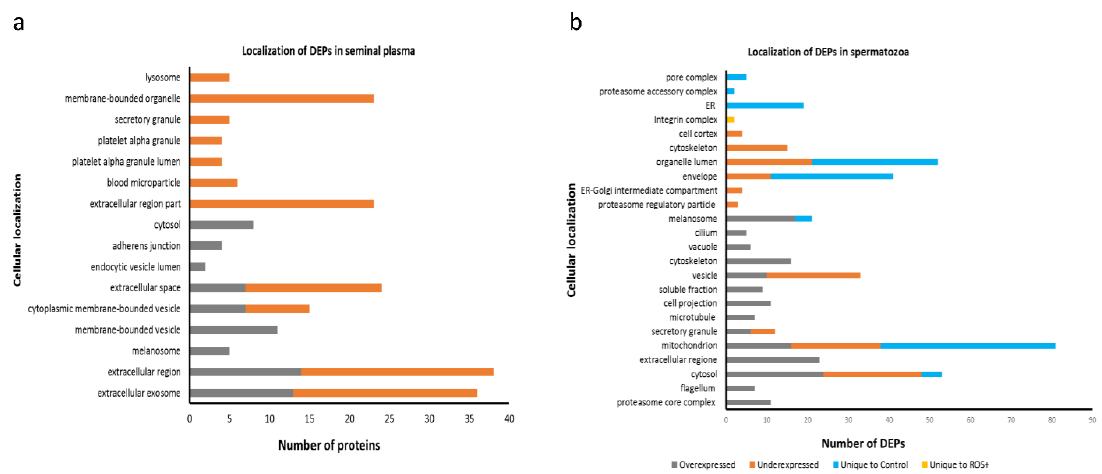
Figure 2. Localization of differentially expressed proteins (DEPs) in: ( a ) seminal plasma; and ( b ) spermatozoa. The number of DEPs that were overexpressed (grey), underexpressed (orange), unique to control (blue), and unique to ROS+ (yellow) are shown for seminal plasma and spermatozoa.